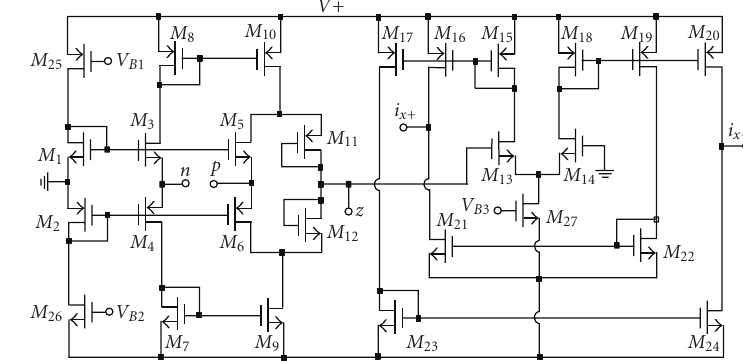
Figure 2: CMOS-based CDTA.